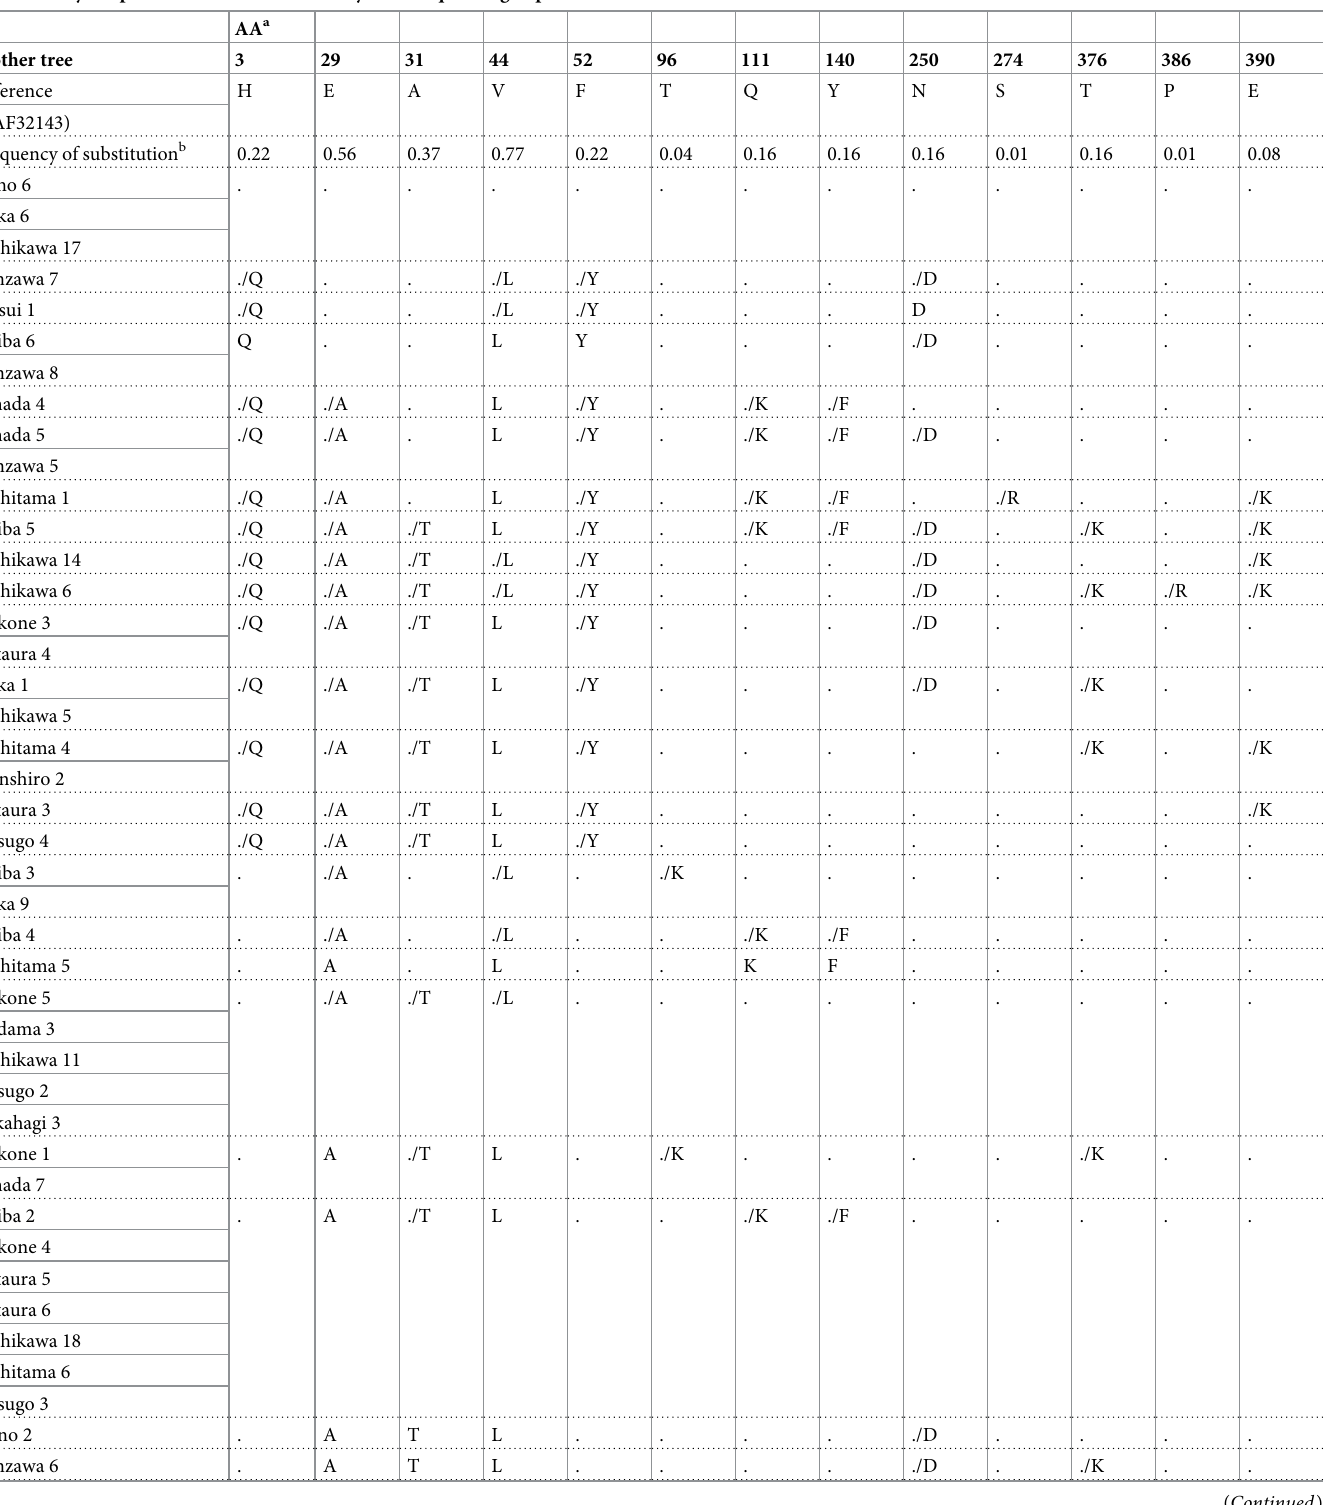
Table 1. Polymorphisms of Cha o 2 deduced by DNA sequencing of plus trees from the seed orchards of Chiba Prefecture. AA a Mother tree 3 29 31 96 140 250 274 376 386 390 Reference H E A (BAF32143) Frequency of substitution b 0.22 0.56 0.37 0.16 Miho 6 . . .